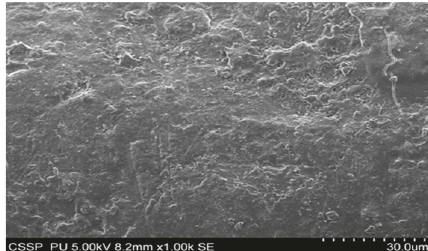
Figure 4: Scanning electron microscopy of ENa.